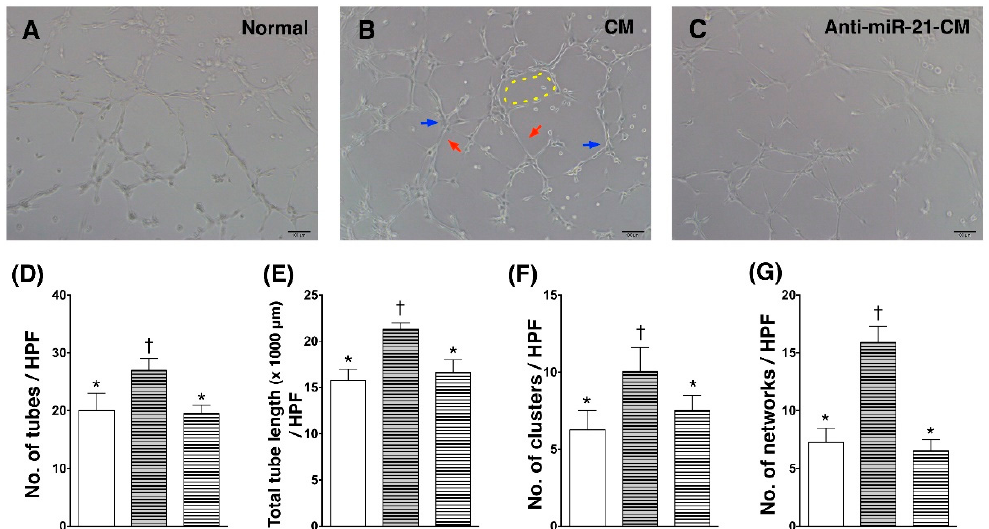
Figure 5. Inhibition of miR-21 reduced the e ff ect of conditioned medium on angiogenic enhancement in endothelial cells. ( A ) Matri-gel analysis on normal control human umbilical vein endothelial cells (HUVEC). ( B ) Matri-gel analysis on HUVECs incubated with conditioned medium derived from OGD-treated cardiomyocytes. ( C ) Matri-gel analysis on HUVECs incubated with conditioned medium derived from OGD-treated cardiomyocytes with anti-miR-21 pre-transfection. ( D ) Calculation of tube formation (red arrows). ( E ) Calculation of total tube length. ( F ) Calculation of cluster formation (blue arrows). ( G ) Calculation of network formation (yellow dotted line). CM, conditioned medium derived from OGD-treated cardiomyocytes. Anti-miR-21-CM, conditioned medium derived from cardiomyocytes pre-transfected with anti-miR-21 (20 nM). Groups with di ff erent symbols (*, † ), p < 0.05. n = 6 for each group.